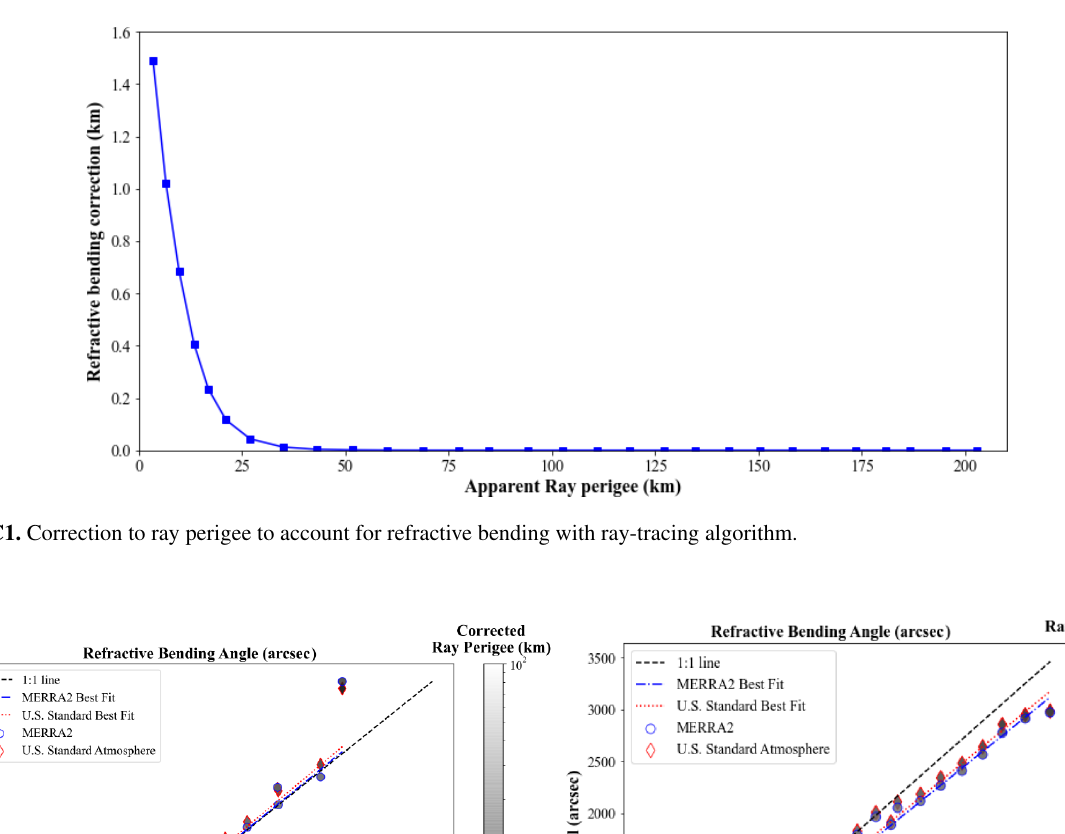
Atmos. Meas. Tech., 16, 2129–2144,